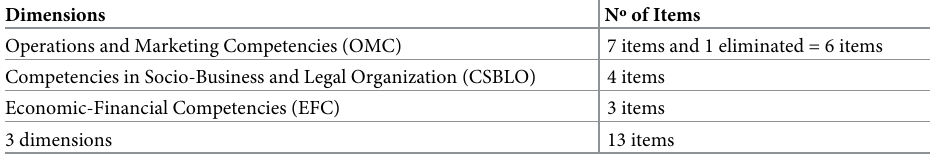
Table 4. Dimensions of basic entrepreneurial competencies.